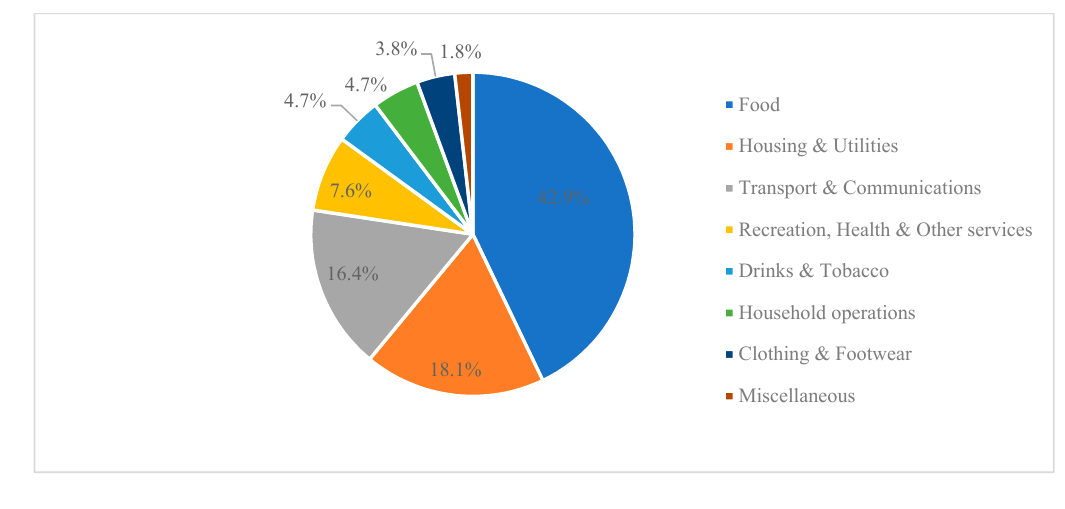
Figure 5. HCPI Series 2 (2005 Q4) categories & weights. Data from Central Bank of Solomon Islands (CBSI